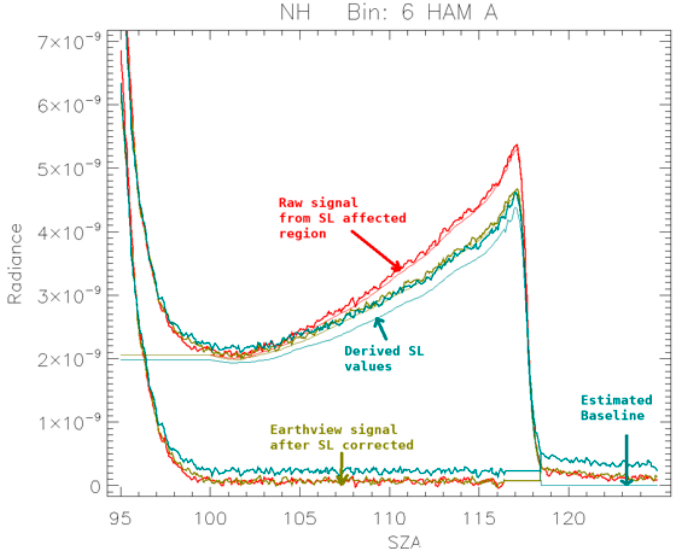
Figure 10. An illustration of stray light correction in bin-6: three detectors are presented in differ- ent colors. For each detector, the top noisy curve represents its raw signal. The smooth curve un- derneath the raw signal is its stray light estimate. After stray light correction, the signal is shown at the bottom.